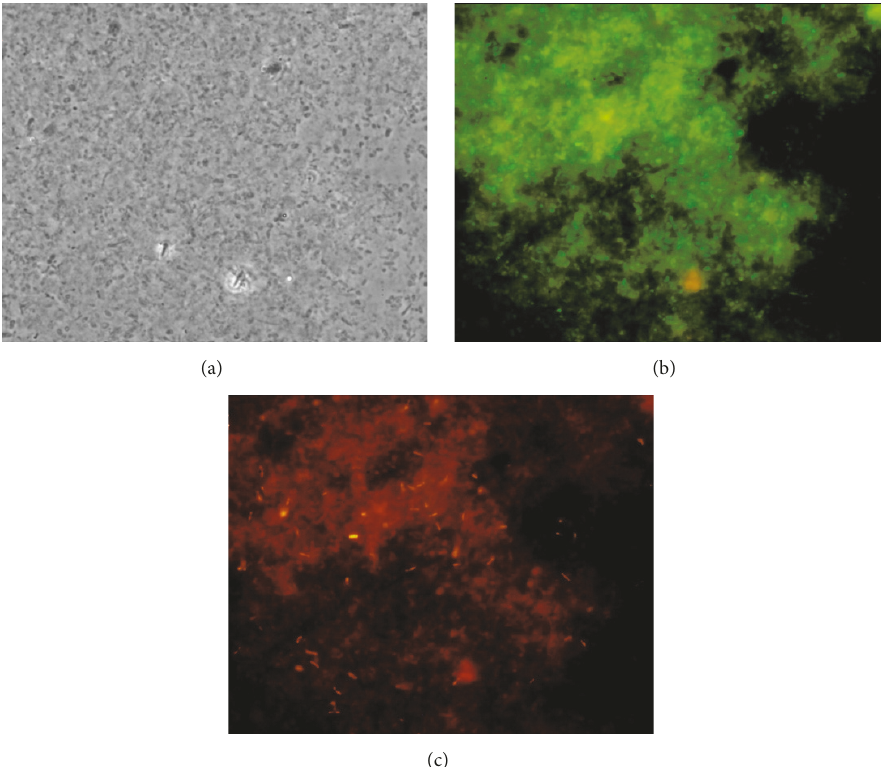
Figure 7: Micrographs (magnification: 1000x) of the flocs under phase contrast and epifluorescence. Comparison of the same floc area. Hybridization target: viable bacteria and Gammaproteobacteria. (a) Phase contrast. Identical microscopic fields under fluorescence: (b) detection of all viable bacteria and (c) analysis with a specific probe for